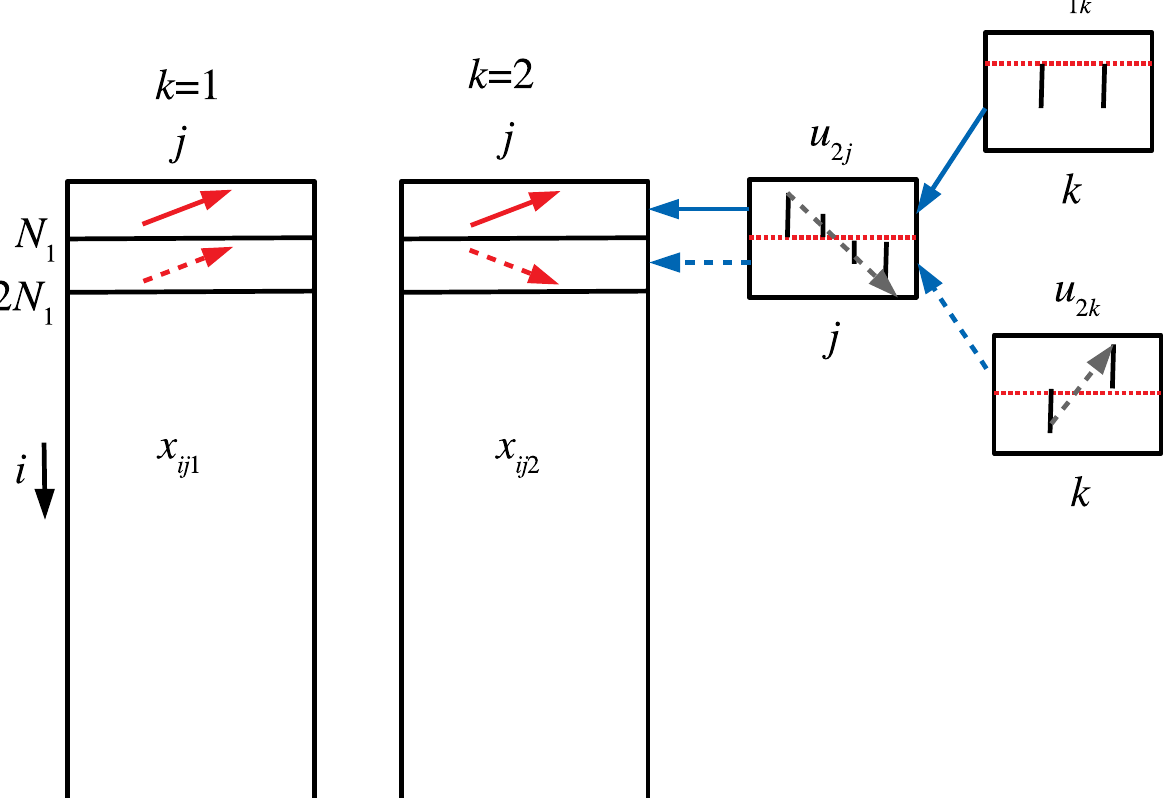
Figure 7. Schematic figure that explains the correspondence between x ijk , i ≤ N 1 (red solid arrows) and u 2 j , u 1 k and that between x ijk , N 1 < i ≤ 2 N 1 (red broken arrows) and u 2 j and u 2 k , respectively. TD based unsupervised FE ℓ 1 = 3 ℓ 1 = 2 Adjusted P -values > 0.01 ≤ 0.01 > 0.01 ≤ 0.01 i ∈ [ 1, N 1 ] 990 0 i ∈ [ N 1 + 1,2 N 1 ] 990 i ∈ [ 1, N 1 ] 0 Table 10. Confusion matrices of selected is between true and those selected by TD-based unsupervised FE applied to synthetic data set 1.